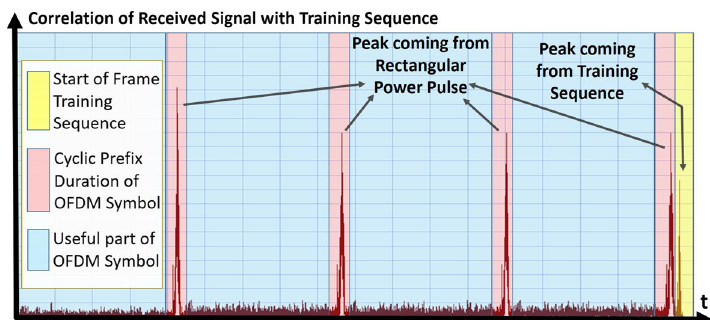
Fig. 13 The figure shows an example of flipping and correlating four received CP-OFDM symbols with a certain training sequence. This simple synchronization method can provide errors since the starting of the frame is not going to be detected properly (i.e., synchronization